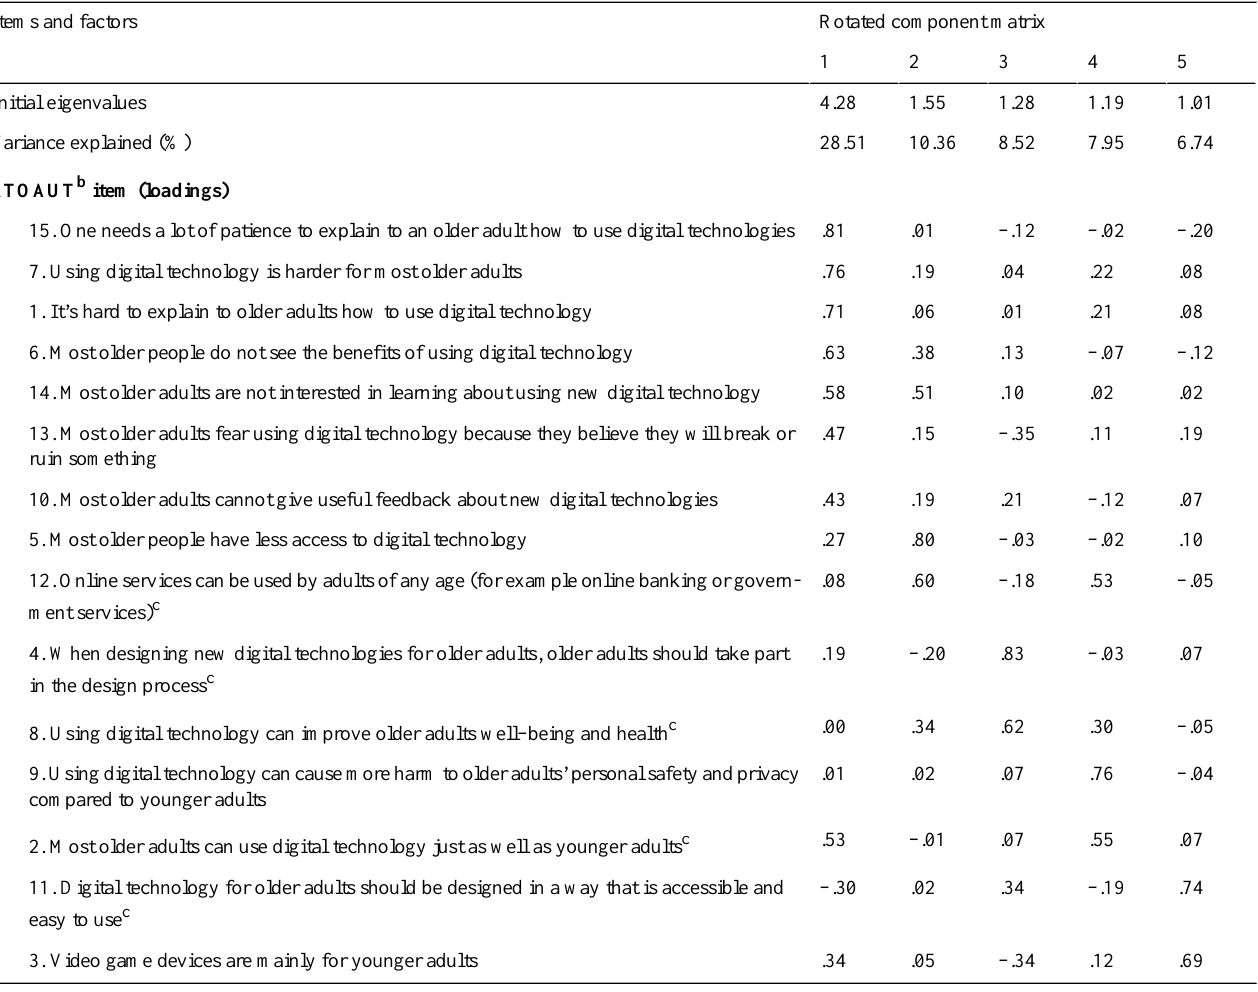
Table 1. Initial eigenvalues and explained variance and loadings after Varimax rotation of ATOAUT items as sorted by loading size (N=97). a